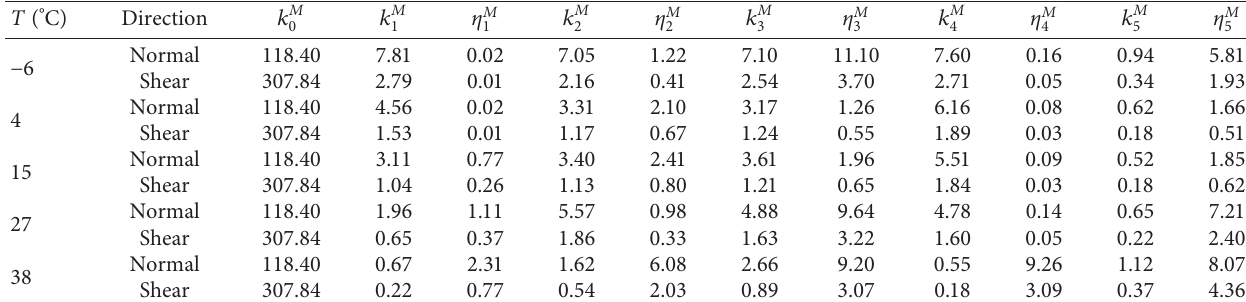
Table 3: Parameters of the numerical samples using the M-model.